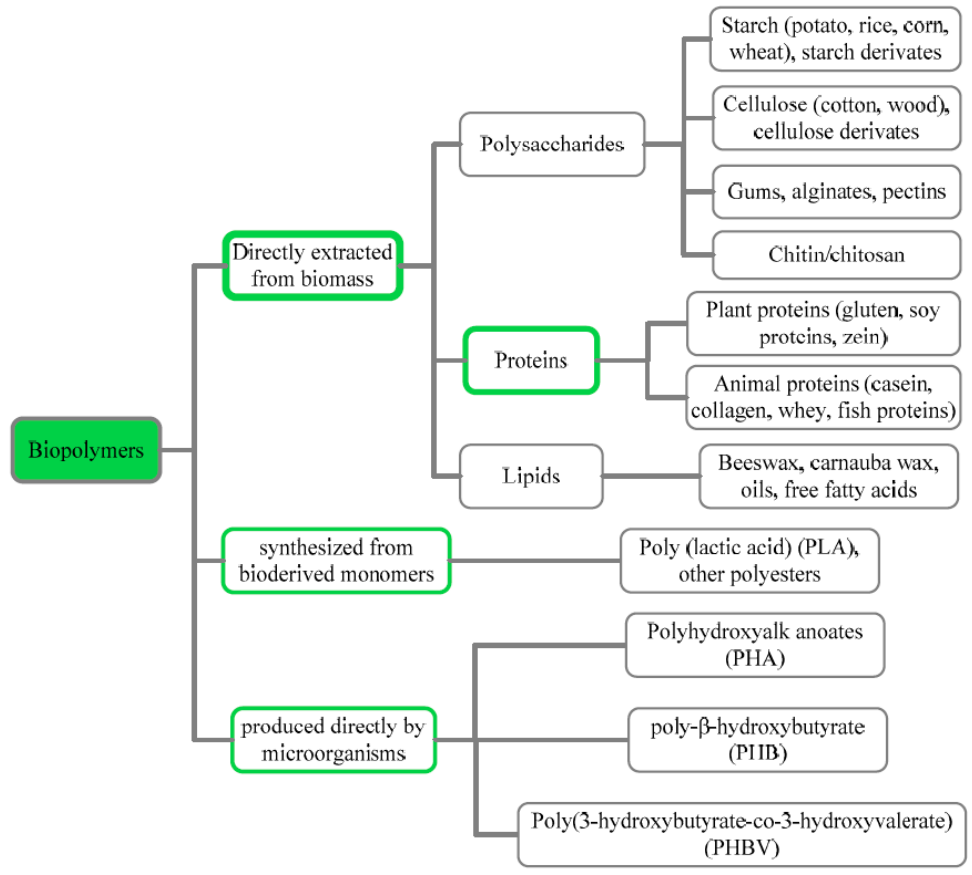
Figure 1. Classification of biopolymers (reproduced with copyright permission from Chen et al. [24]). Table 1. Cases of study of biopolymers and their effects in food ‐ packaging applications.